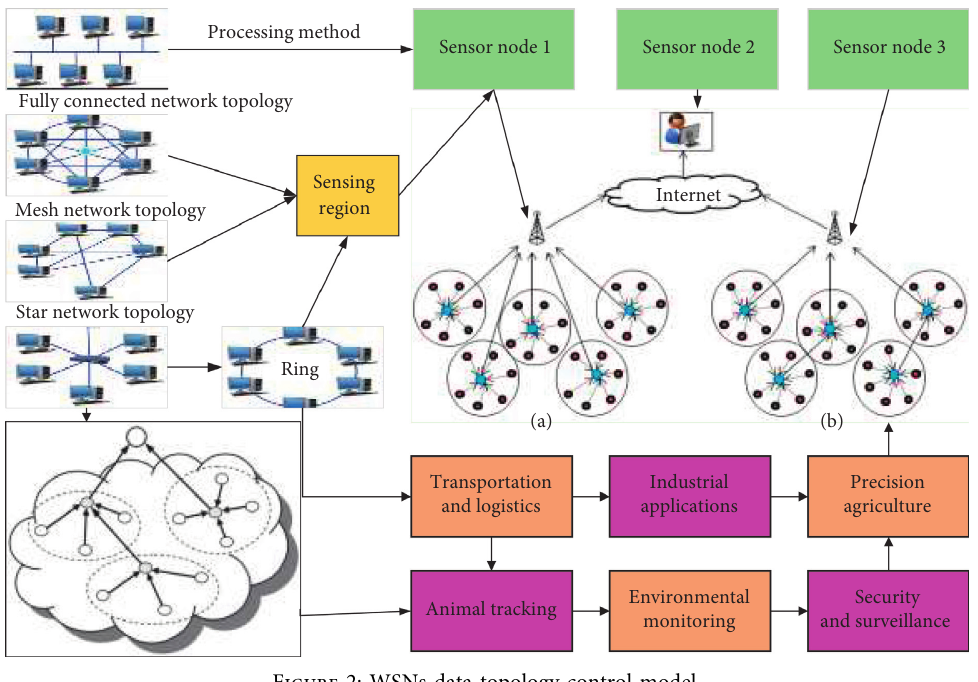
Figure 2: WSNs data topology control